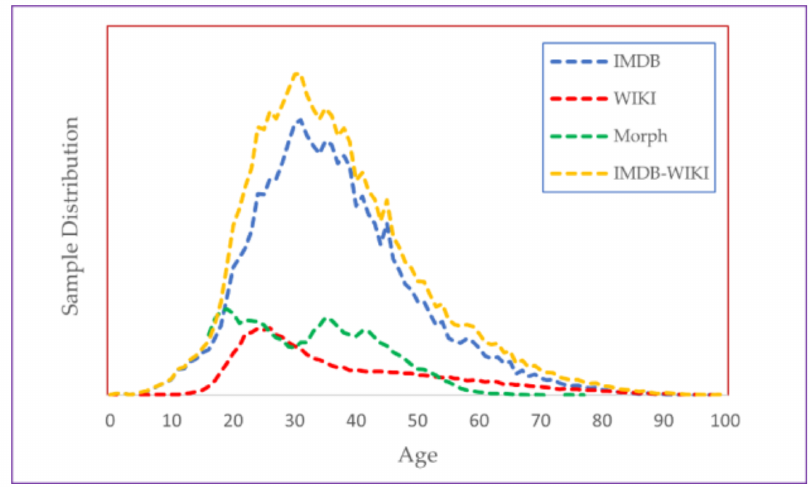
Figure 9. Distribution of age samples among the datasets experimented in our